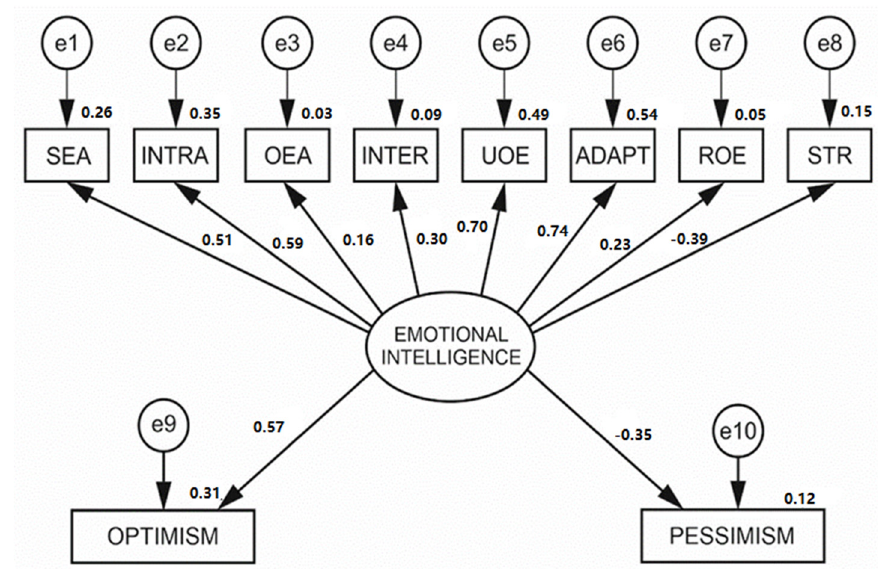
Figure 2. Multi-group structural equation model for men.